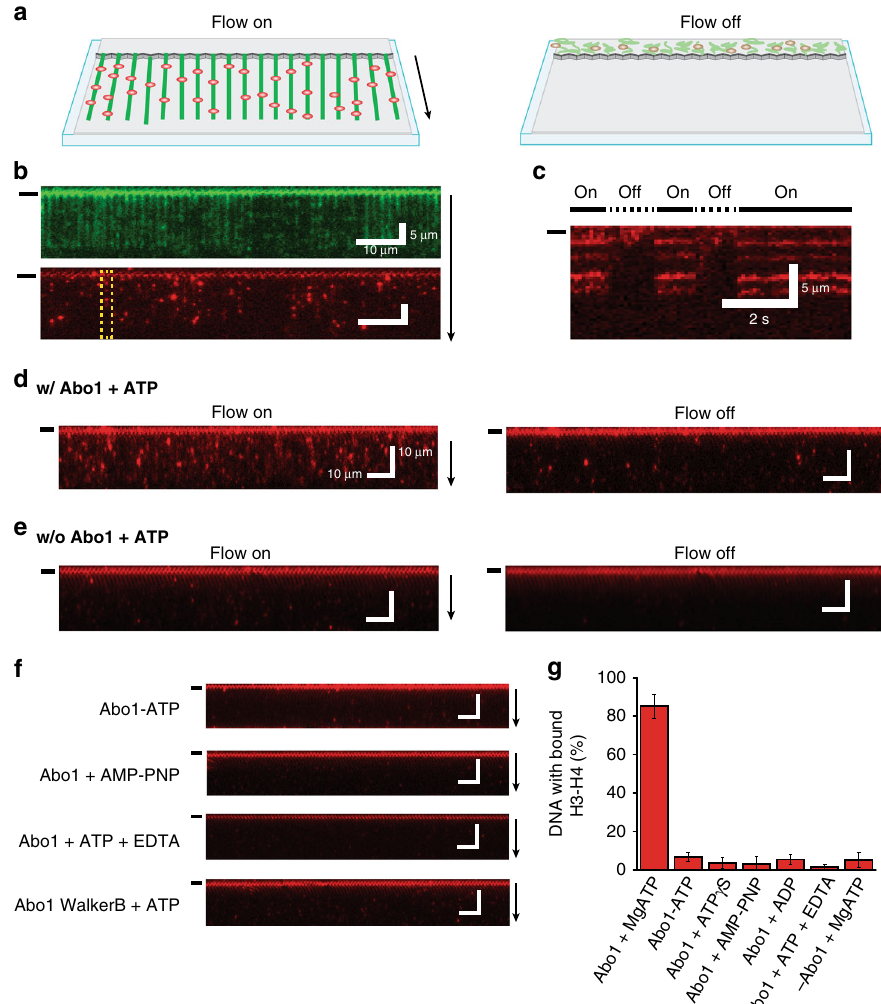
Fig. 2 A single-molecule DNA curtain assay shows ATP hydrolysis-dependent H3 – H4 loading onto DNA by Abo1. a Schematic diagram of the single- tethered DNA curtain assay for histone deposition. In the presence of fl ow, DNA molecules are aligned and extended at the barrier, and can be visualized by TIRF microscopy. When the fl ow is stopped, DNA molecules recoil out of the evanescent fi eld. b (Top) An image of DNA molecules (green) stained with YOYO-1. (Bottom) An image of Cy5-labeled H3 – H4 (red) loaded by Abo1 in the presence of ATP. c Kymograph of a single DNA molecule in the yellow dashed box in b . When the fl ow is turned off, the Cy5 fl uorescence signals disappear, ensuring that H3 – H4 is speci fi cally bound to DNA and not the surface. d , e Cy5-labeled H3 – H4 loading onto DNA observed by the DNA curtain assay in the presence (w/ Abo1 + ATP) ( d ) or absence ( e ) of Abo1 (w/o Abo1 + ATP). In all images above, black bars left to image and arrows right to image indicate barrier position and fl ow direction, respectively. Scale bars represent 10 μ m length unless indicated. f The ATP hydrolysis-dependence of Abo1 histone deposition activity as shown by DNA curtain assays with fl ow. g Quanti fi cation of histone H3 – H4 deposition activity under different nucleotide conditions by measuring the fraction of DNA with bound H3 – H4. Error bars represent the standard deviation (SD) of three experiments, and 100 – 200 molecules per experiment were analyzed for the quanti fi